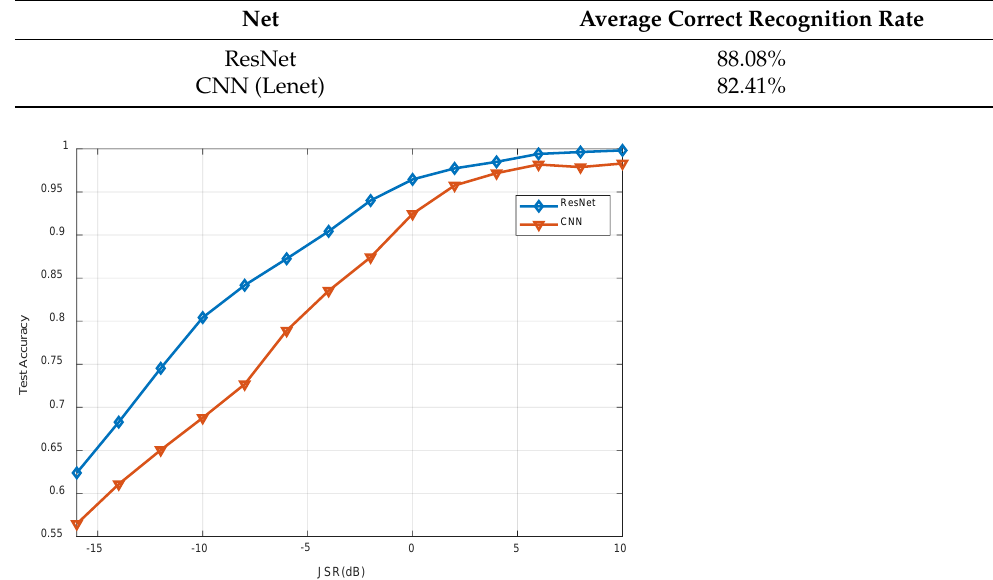
Figure 8. Performance comparison of ResNet and CNN under single-node method. Experiment 2: Performance comparison of jamming recognition under different number of nodes in the hard-fusion based method.